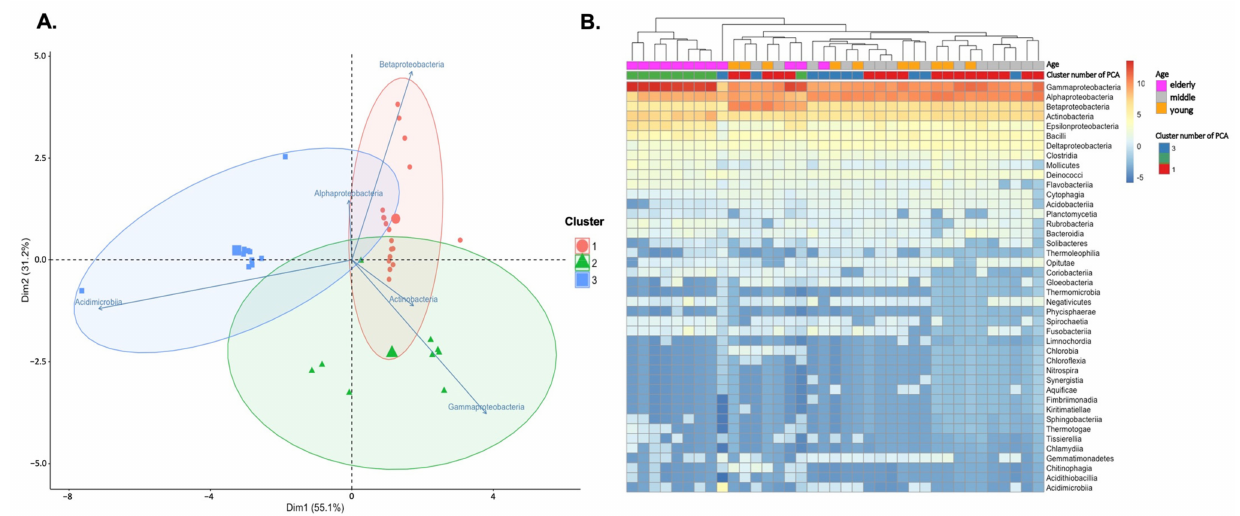
Figure 4. Relative abundance of class level taxa detected in the blood microbiota. ( A ) Principal component analysis (PCA) allowed for a refinement of the overall subjects into clusters 1, 2, and 3. The color indicates the identity of each sample. A PCA plot of samples correlated with the five most common classes after clr transformation (frequency > 0.01 in any sample). ( B ) Heatmap showing relative abundance of clr-transformed taxa at the class level, using the Euclidian method (dendrogram). The young were under 40 years old, middle-aged were from 40 to 60 years old, and elderly were over 60 years old; the cluster number of PCA (cluster) for each subject is indicated by the top